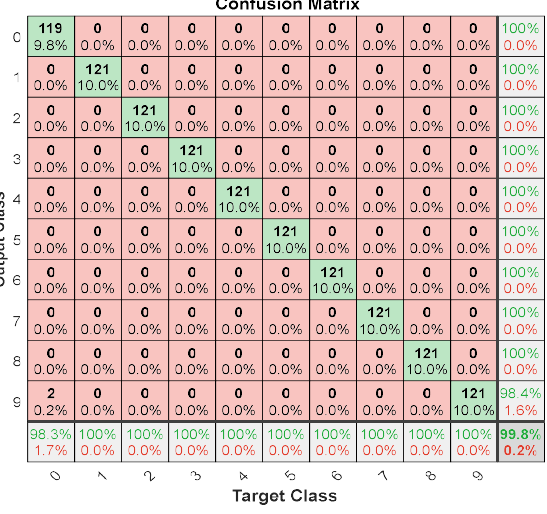
Figure 18. A confusion matrix of FE for LFM signals by CNN.